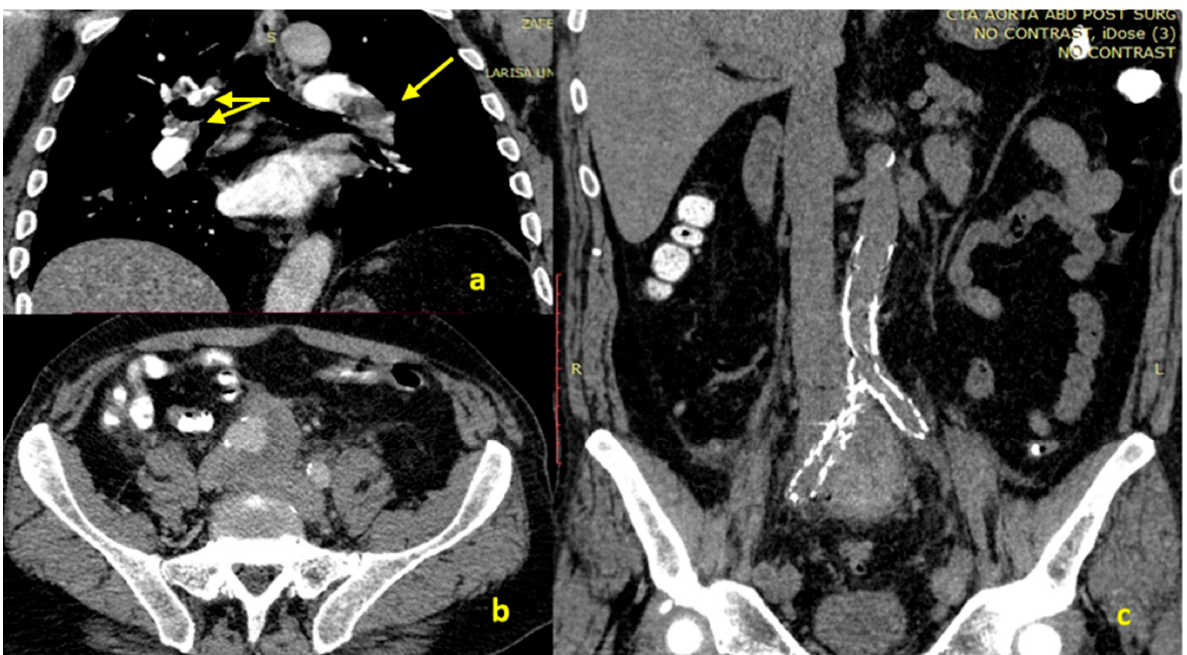
Figure 1. CT pulmonary angiography showing pulmonary embolism ( a ), coronal 63 view of CT of the abdomen presenting the contained rupture of the aneurysm ( b ), CT of 64 the abdomen after stent placement ( c ).